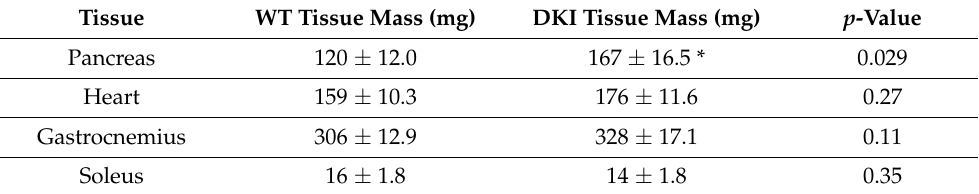
Figure 1. The double knock-in (DKI) mutation utilized to disrupt whole-body AMP-activated protein kinase (AMPK)- glycogen binding is associated with increased body mass and adiposity. ( a ) Schematic of AMPK wild type (WT) versus DKI mouse model in which tryptophan residues critical for AMPK-glycogen binding within the AMPK β 1 and β 2 subunit isoforms (predominantly expressed in the primary glycogen storing tissues liver and skeletal muscle, respectively) were mutated to alanine, resulting in chronic whole-body disruption of AMPK-glycogen binding. ( b ) Growth was assessed in male DKI and WT mice fed a standard rodent chow diet. EchoMRI analyses revealed that DKI mice had ( c ) greater total fat mass between the ages of 10 and 15 wk and ( d ) increased total lean mass between ages 13 and 17 wk, with the exception of 15 wk. Fed male mice, n = 11–30, 9–18 wk. Mice were culled and ( e ) epididymal fat pads, ( f ) quadriceps muscle, ( g ) and liver were excised and weighed. Fed male mice, n = 11–14, 17–20 wk. * p < 0.05, ** p < 0.01, *** p < 0.001, **** p < 0.0001. Table 1. Tissue masses from male WT and AMPK DKI mice. Pancreas, heart, gastrocnemius muscle, and soleus muscle were collected from mice in the fed state and